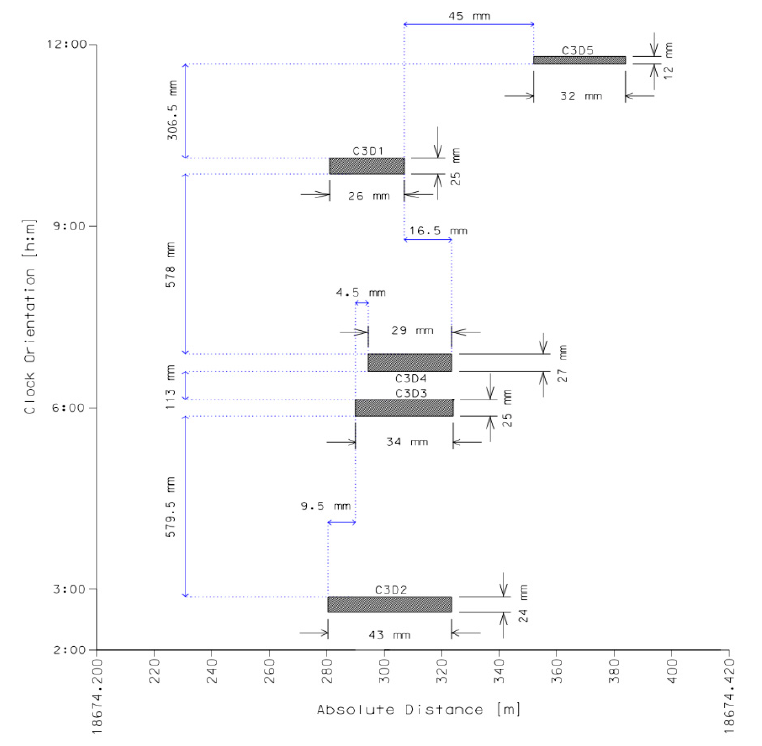
Figure 5. Graphical presentation of defects spacing in group 3. Source: Author’s analysis.